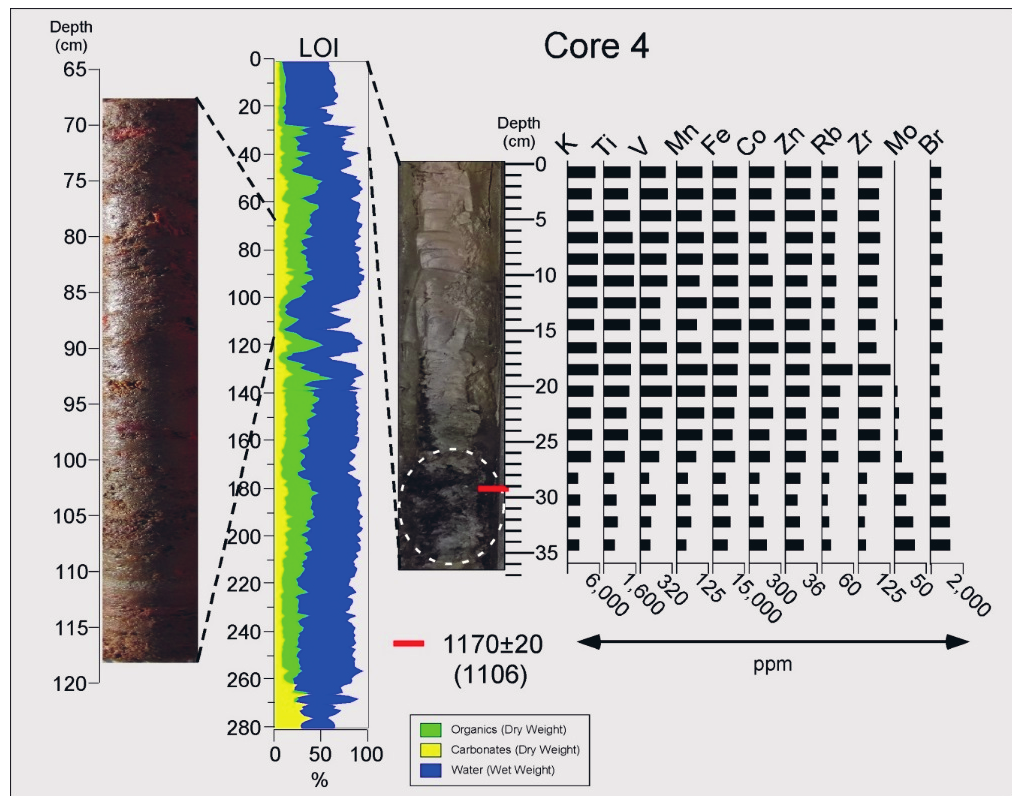
Figure 7. Sediment core 4 from near the center of the lake. Above a calcareous bottom mud from 281 to 262 cm (LOI diagram, center left), the core is predominately organic as shown by the section from 67 to 117 cm (left). Above a boundary at 27 cm, marked by the presence of encapsulated clasts from the underlying material (center right), the sediments abruptly change to a lacustrine mud with an altered geochemical signature (right). The red line marks the depth of the dated sample which returned a median calibrated date of 1106 year